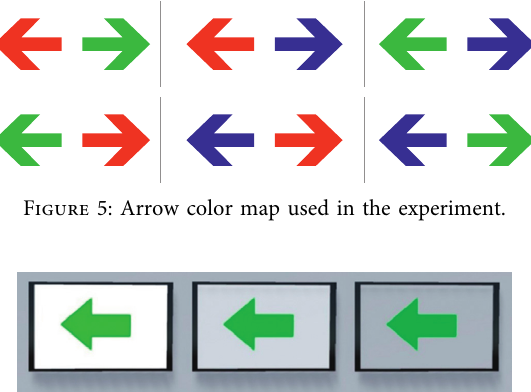
Figure 6: Schematic diagram of indicator brightness.